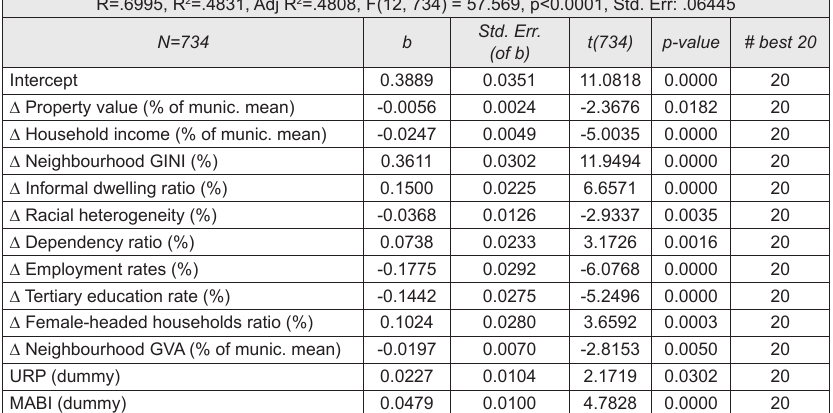
Table 2: Multiple regression analysis of factors related to changes in neighbourhood poverty,